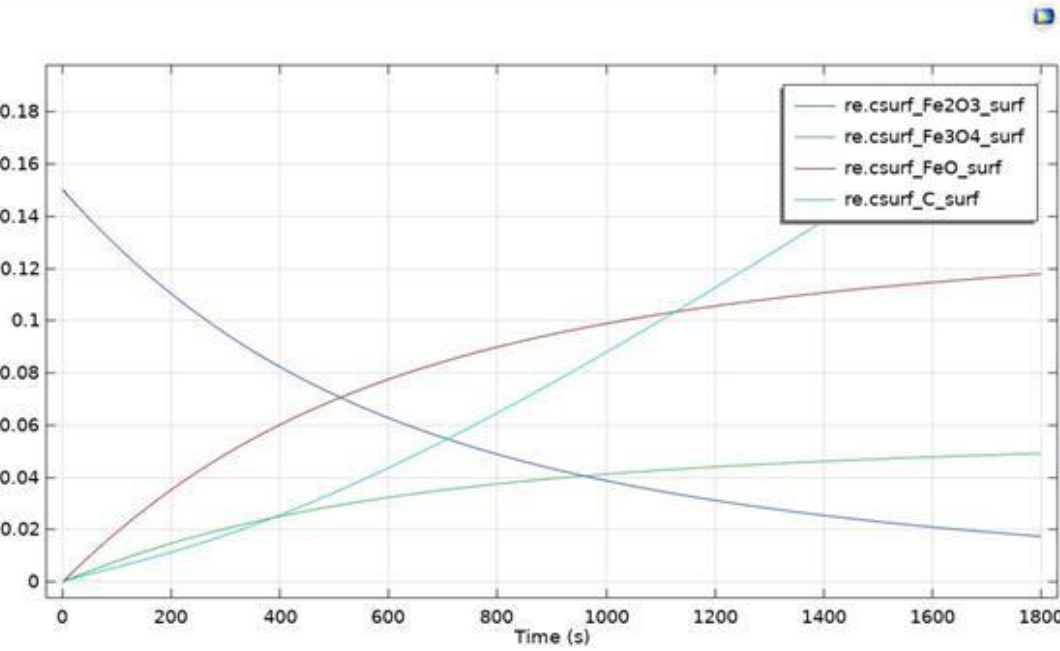
Figure 5. Surface concentrations in mol/m 2 of the solid components in the reactor.